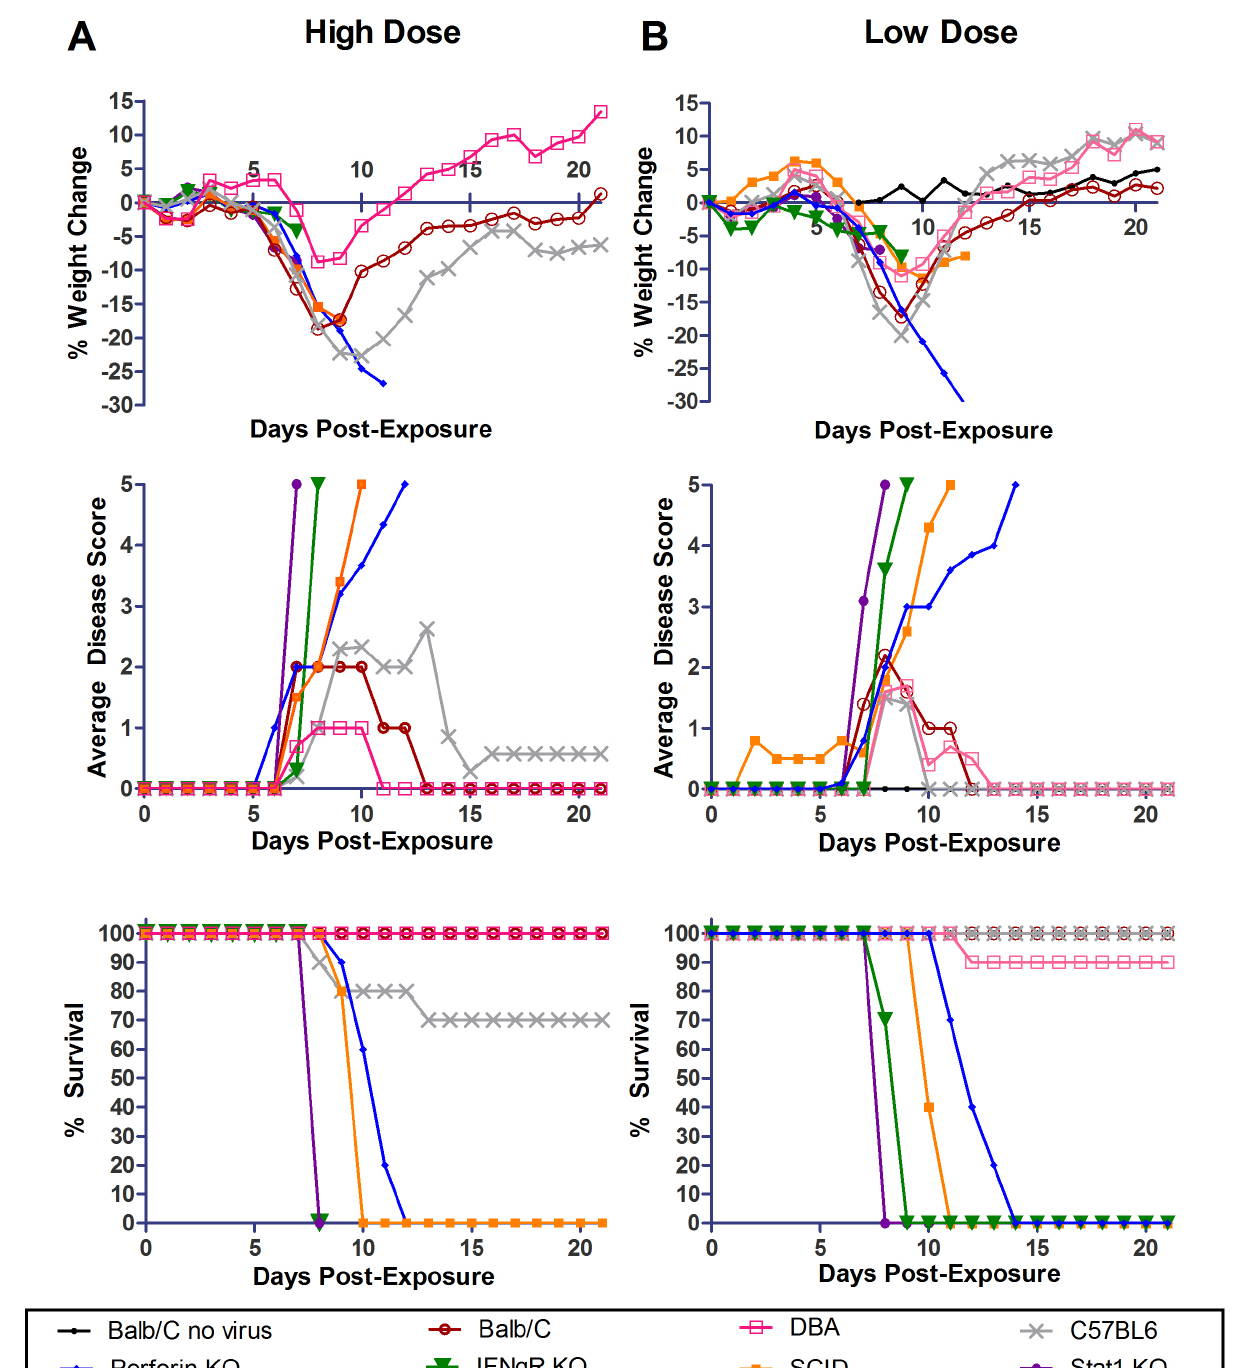
Figure 1. Exposure of WT and immunocompromised mice to aerosolized WT & MA-EBOV (high dose). Percent weight loss, clinical disease score and survival of BALB/c, DBA-2, C57BL/6, Perforin KO, IFN γ R KO, SCID and Stat1 KO mice are shown for 0-21 dpe (n = 10 per mouse strain) following high 2461 ± 201 pfu (A) or low 228 ± 26 pfu (B) dose aerosol exposures. A BALB/c no virus control was included in the low dose challenge experiment